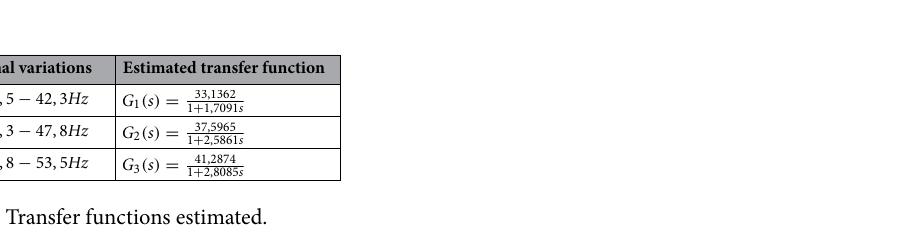
Table 3. Transfer functions